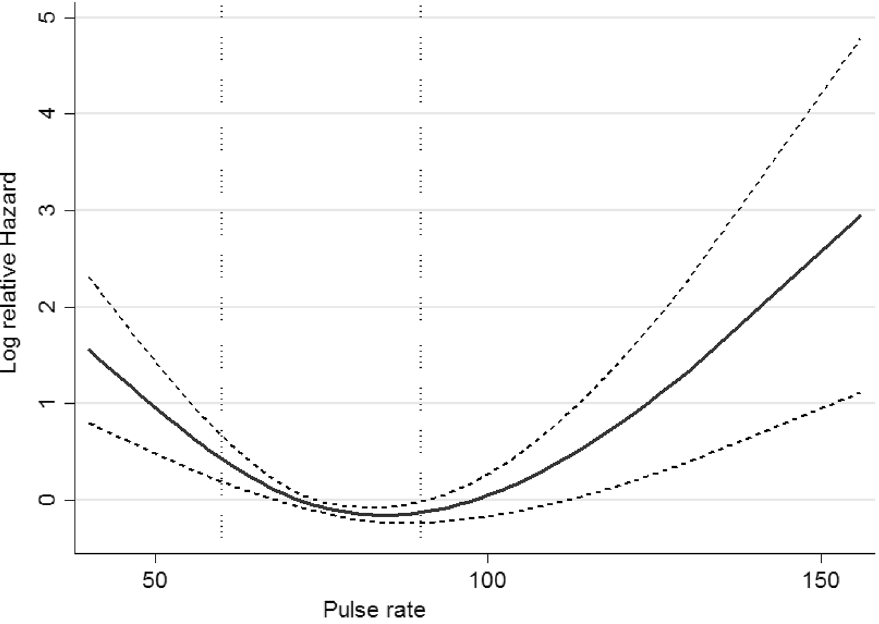
Figure 2. Restricted cubic spline curve for association (95% CI) of pulse rate with SCD events among the Tehranian population: Tehran Lipid and Glucose Study